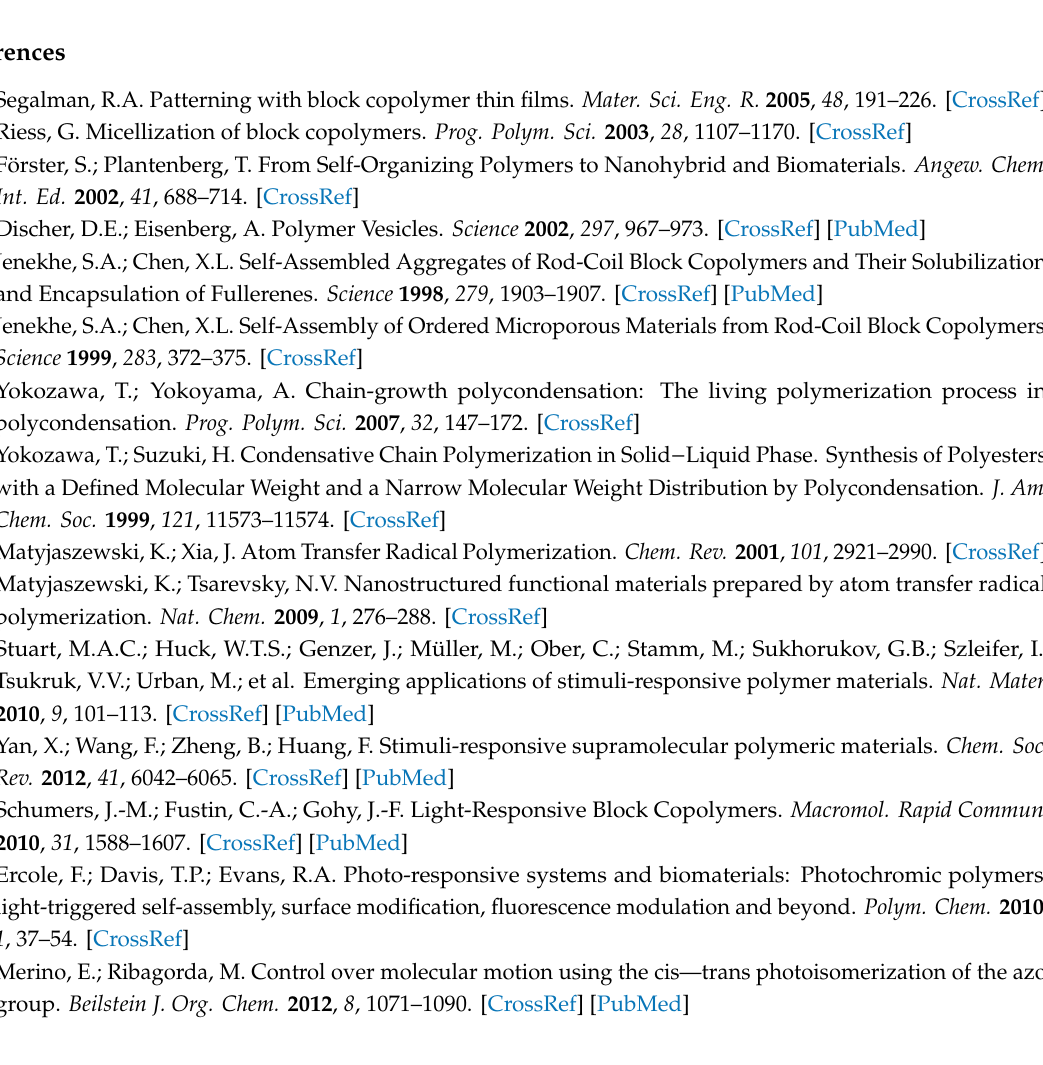
Figure S1: THF-GPC profiles of PAEAz derivatives, Figures S2–S4: 1 H NMR spectra with calculation of % OEGMA and molecular weights of DRBCPs, Figure S5: THF-GPC profiles of DRBCPs, Figure S6: TGA curves of the DRBCPs, Figure S7: DSC diagrams of the DRBCPs, Figures S8 and S9: UV-vis absorption spectral changes of DRBCPs, Figure S10: Reversible thermo-responsive behaviors of DRBCPs in aqueous solution. Figure S11: Visualization of transmittance change by controlling